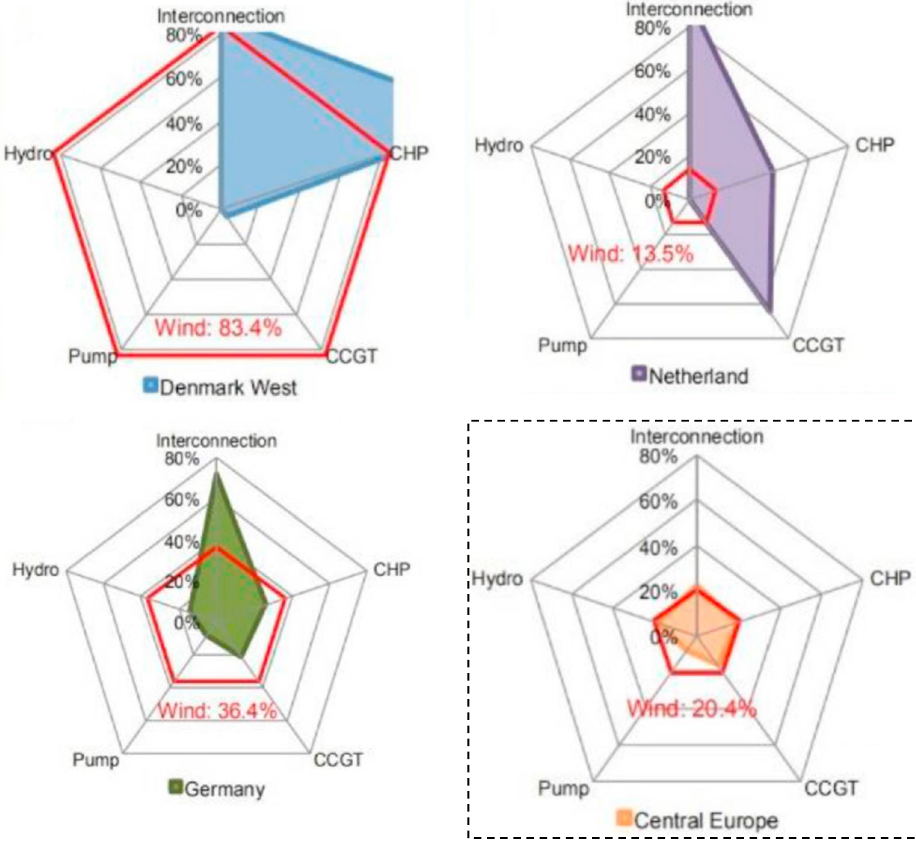
Figure 3. Flexibility graphs of the Central Europe region and three selected countries with wind penetration levels. Adapted from Ref. [33].